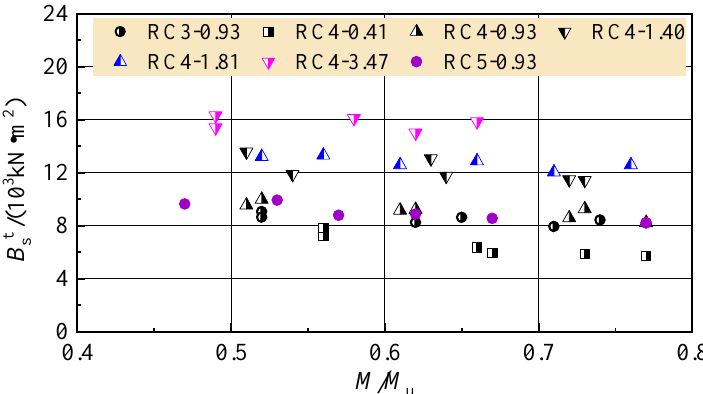
Figure 9. Flexural stiffness changed with moment of the test beams.